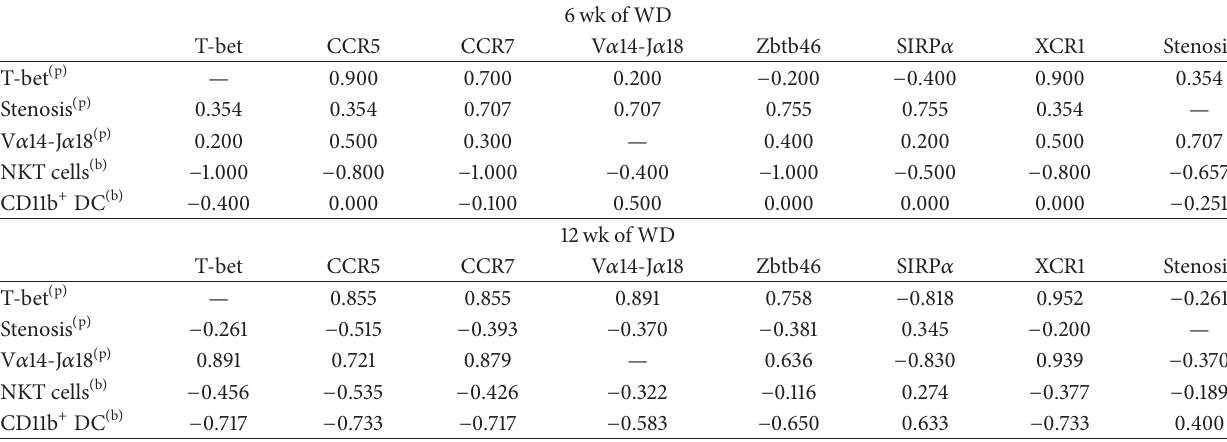
Table 3: Spearman’s rank correlation coefficients ( 𝜌 ) of associations between gene expression results within plaques or between plaques and circulating NKT cells or CD11b + cDC.